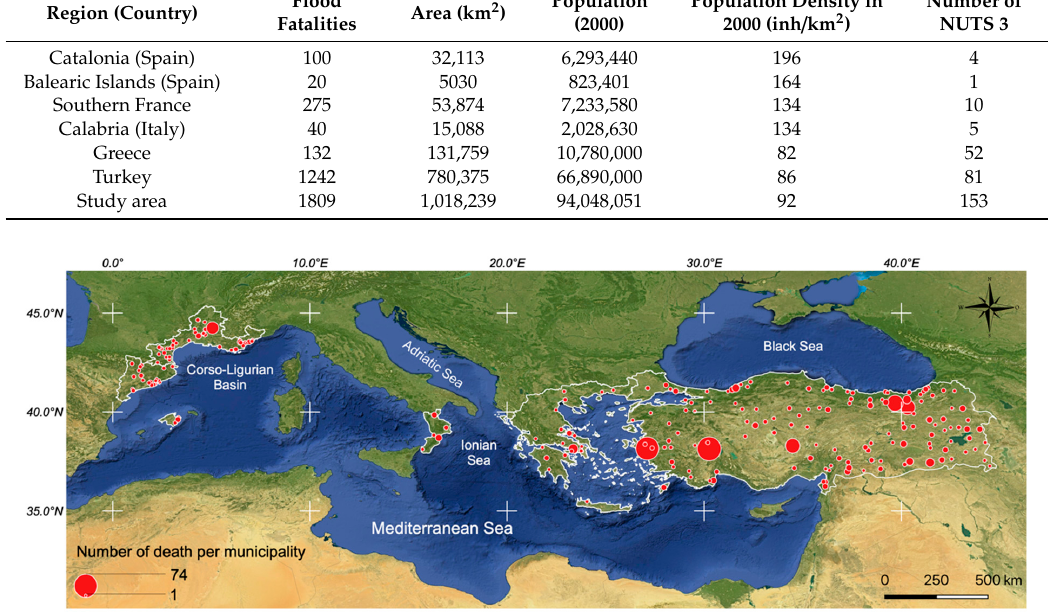
Figure 4. Map of flood fatalities at the municipality level. Table 1. General features by country. NUTS3, Nomenclature of Territorial Units for Statistics Level 3.